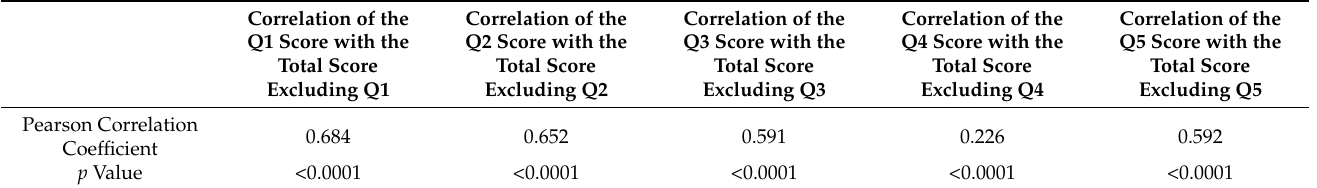
Table 3. The correlation between each ACT questionnaire item and the total score after excluding the score for that